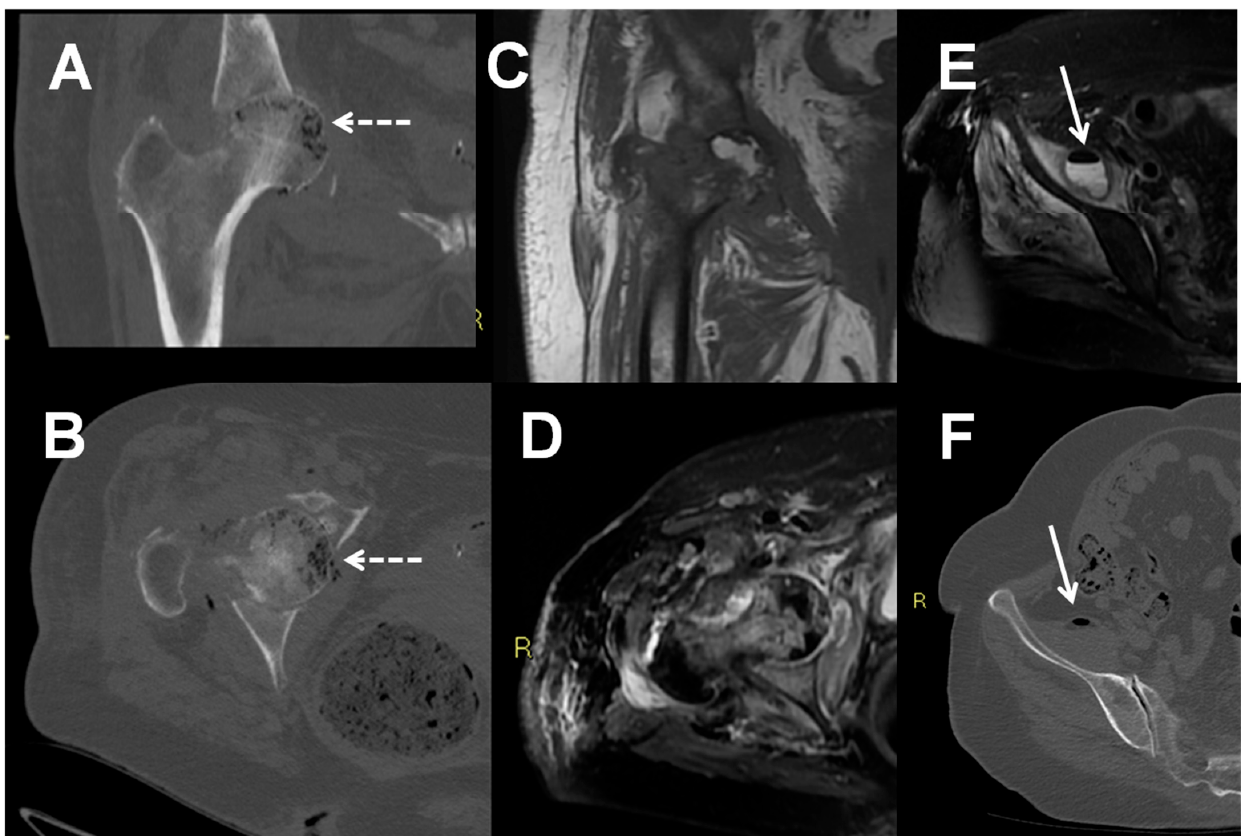
Figure 2. Septic arthritis of the right hip in a 78 years old woman with studied with x-rays ( A ), CT ( B , F ), and MRI ( C , D , E ). CT showed bone intramedullary air coefficients (broken arrows) and involvement of the homolateral ileo-psoas muscle (arrows).